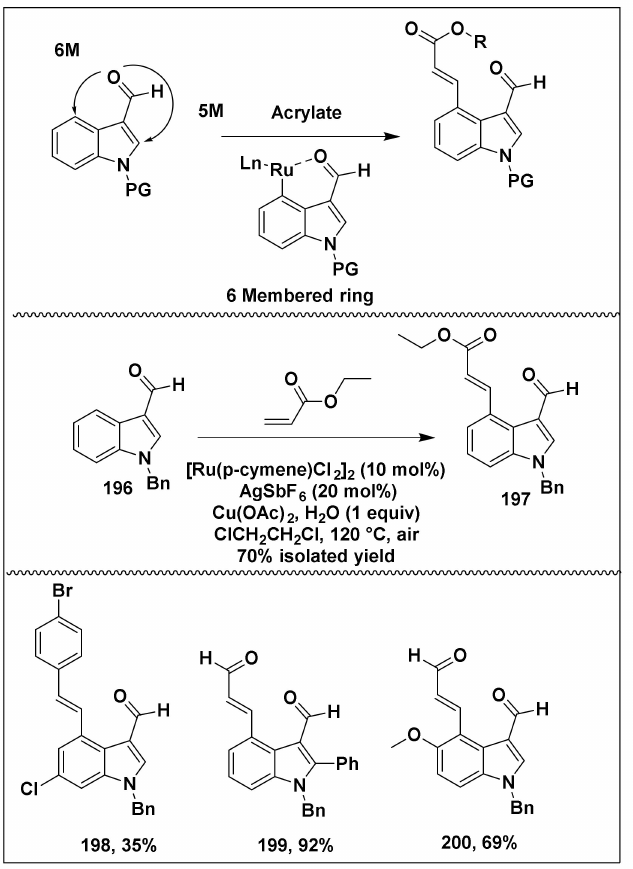
Scheme 47. Selective functionalization of indole at the C4 position via aldehyde function as a directing